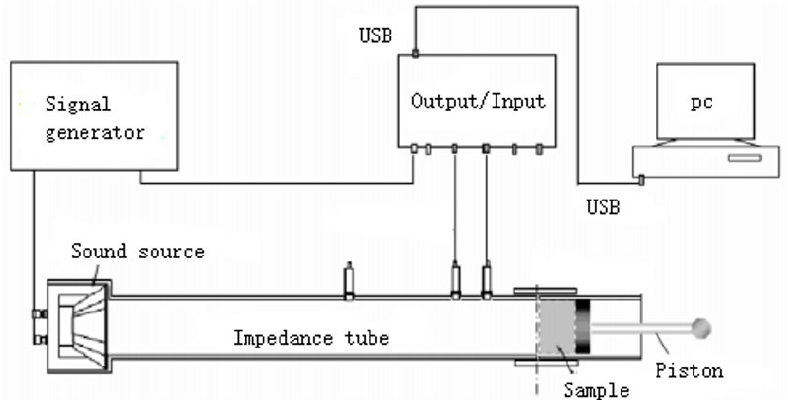
Figure 2. Schematic diagram of the sound absorption test.